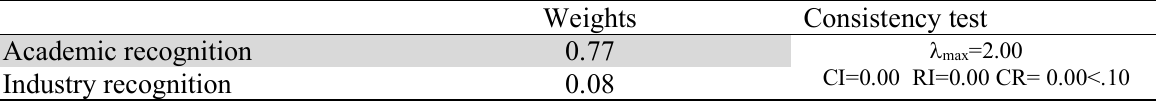
Analysis of the sub-factors of “social recognition”